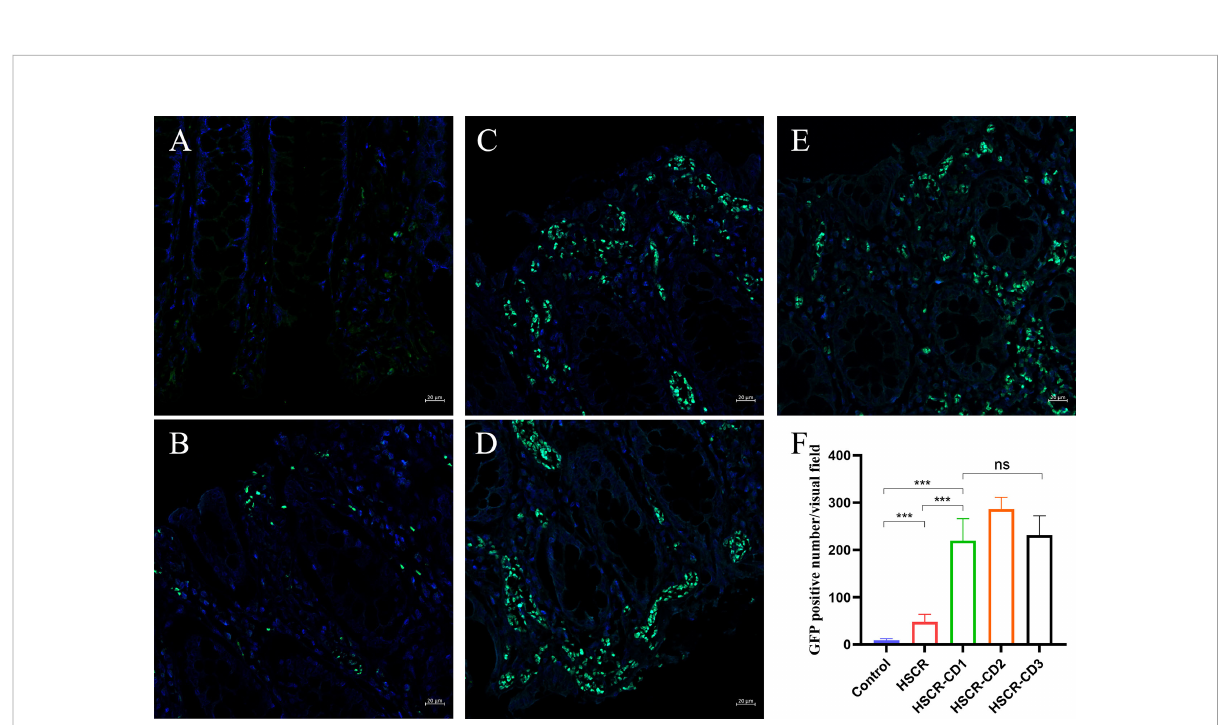
FIGURE 8 Representative immuno fl uorescent staining images of CXCL10 expression in control (A) , HSCR (B) , HSCR-CD patient 1 (C) , HSCR-CD patient 2 (D) , and HSCR-CD patient 3 (E) colon tissues. (F) statistical analysis of GFP-positive cell in each group. ***, p < 0.001. ns, not signi fi cant; HSCR, Hirschsprung disease; CD, Crohn ’ s